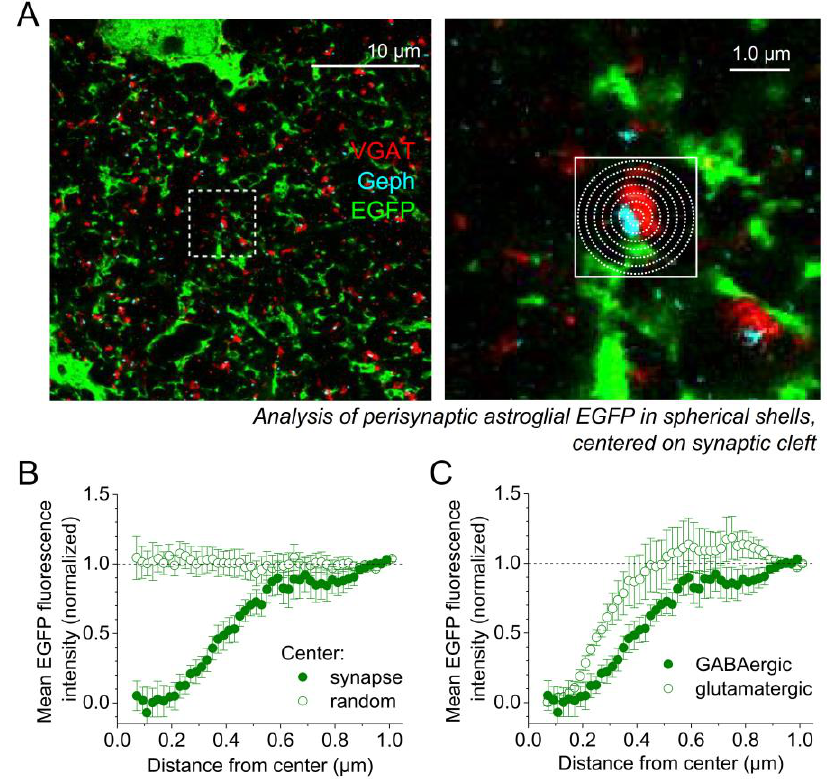
Figure 3. Distribution of astrocyte volume at GABAergic synapses compared to glutamatergic synapses. ( A ) Example of a visualization of an EGFP-expressing astrocyte (green), presynaptic GABAergic terminals (VGAT, red) and postsynaptic gephyrin clusters (Geph, cyan) using expansion microscopy. Left panel: overview. Right panel: zoomed in region outlined in the left panel. The astrocytic volume distribution was analyzed around GABAergic synapses with 1 gephyrin cluster by quantifying the average EGFP fluorescence intensity in concentric three-dimensional shells with increasing diameter centered on the middle of the assumed synaptic cleft between the VGAT and gephyrin cluster (not all shells shown). EGFP fluorescence profiles were averaged and normalized per astrocyte (see main text and methods). ( B ) EGFP fluorescence increases as a function of distance and reaches near maximum levels at 0.6 – 1.0 µm from the synapse (filled circles: analysis centered on synapses, empty circles: random location). Repeated measures one-way ANOVA of synapse- centered analysis: distance p < 0.001, n = 9 average profiles (86 synapses in 9 astrocyte territories from 3 independent expansion microscopy experiments, 3 animals, filled circles). Analysis of 100 randomly placed volumes of interest from the same data set (empty circles, repeated measures one- way ANOVA p = 1.0). ( C ) Comparison of astrocytic EGFP distribution at GABAergic synapses (same data as in ( B ) with a re-analysis of the EGFP distribution at glutamatergic synapses from [13] (121 synapses in 6 astrocyte territories from 3 independent expansion microscopy experiments).